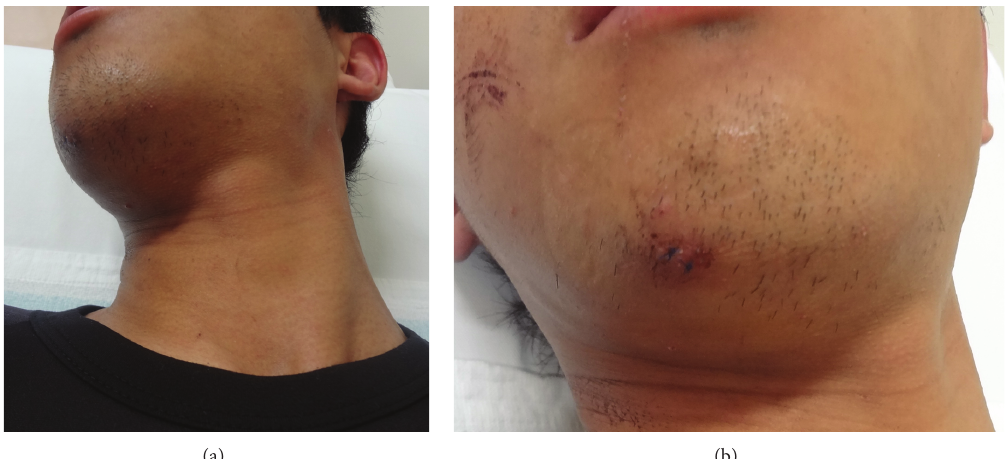
Figure 1: The patient could not move his head at all from its position facing to the right (a). A lacerated wound over the right inferior mandible (b).